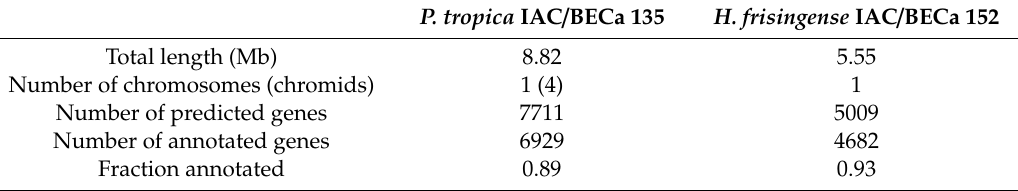
Table 1. Summary of isolate genome assembly, gene prediction, and